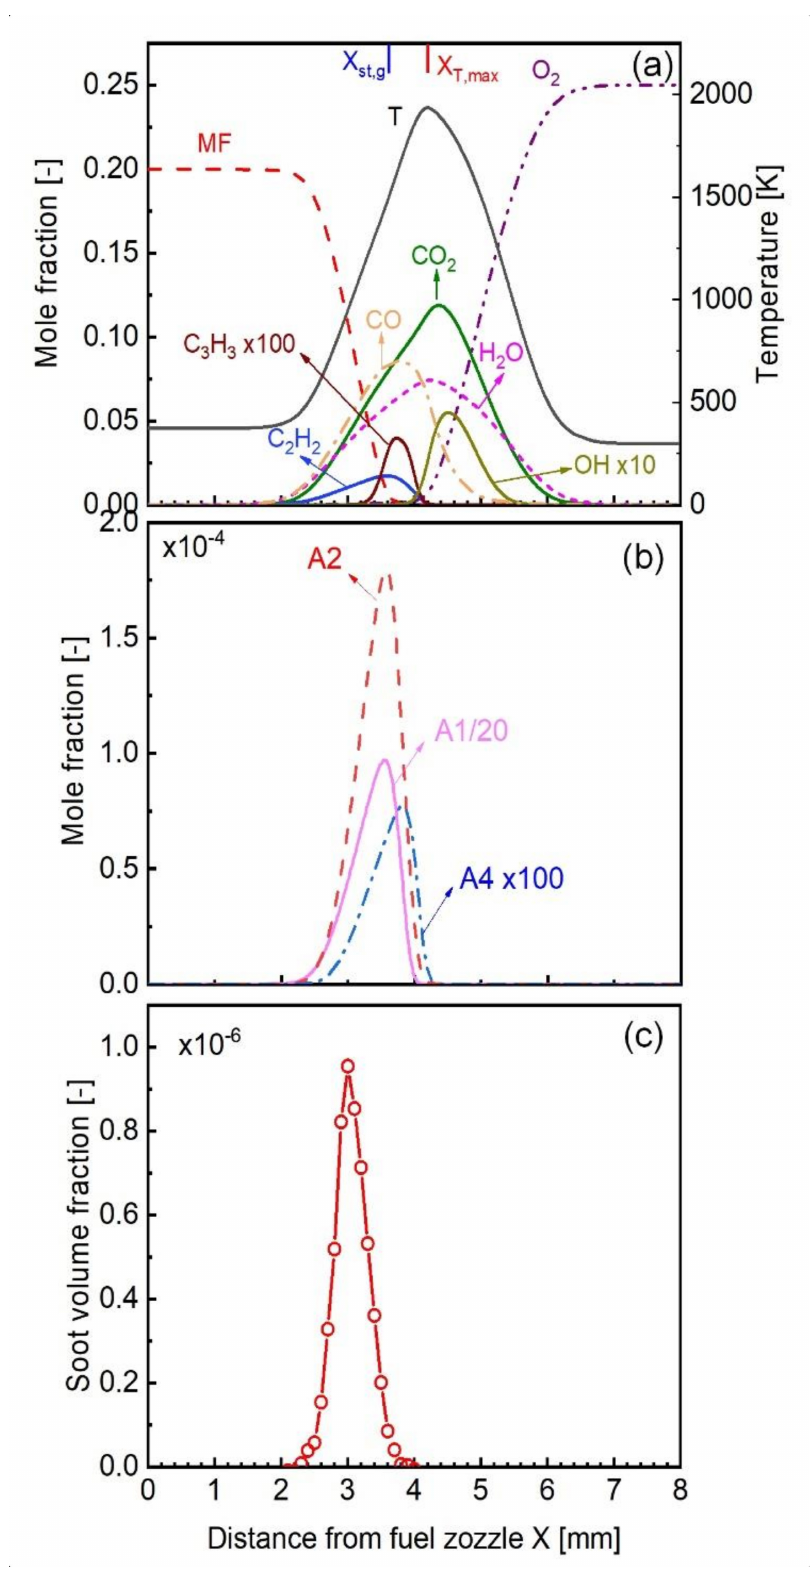
Figure 2. Computed flame structure of the ( a ) temperature profile, concentration of the intermediate species, and ( b ) aromatics species, as well as ( c ) the measured SVF profile for MF counterflow flames (X F = 0.2 and X O =